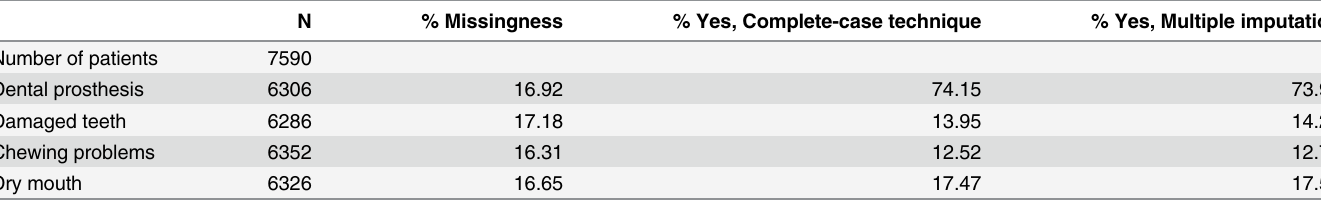
Table 1. Descriptive statistics of oral health-related variables and corresponding missingness.